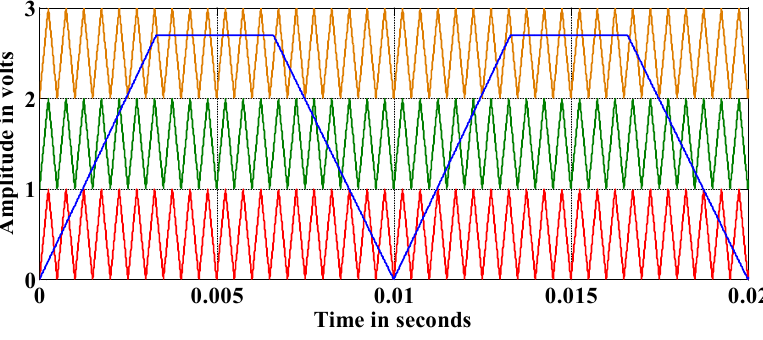
Figure 2. Carrier arrangement for the PDPWM strategy.